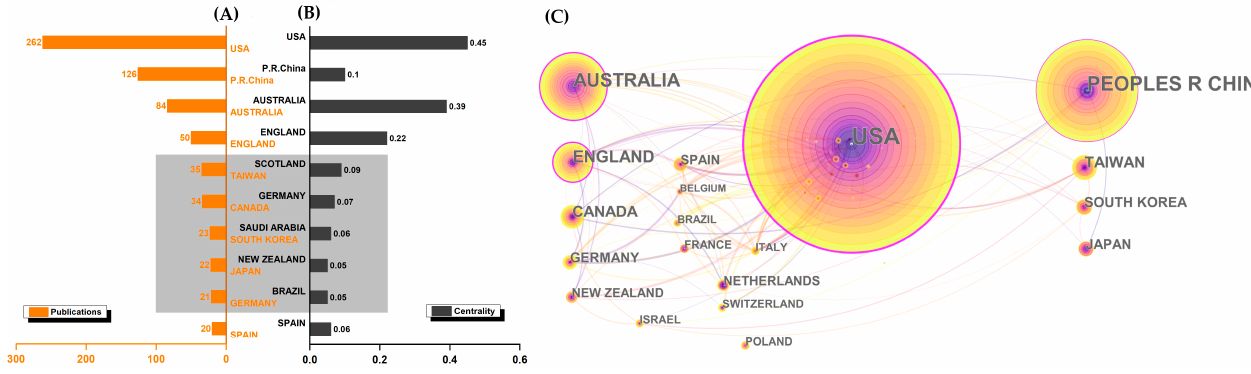
Figure 3. Visualized map of the leading countries and regions. ( A ) Top ten countries and regions by publications; ( B ) top ten countries and regions by centrality; ( C ) cooperation map of countries and regions.